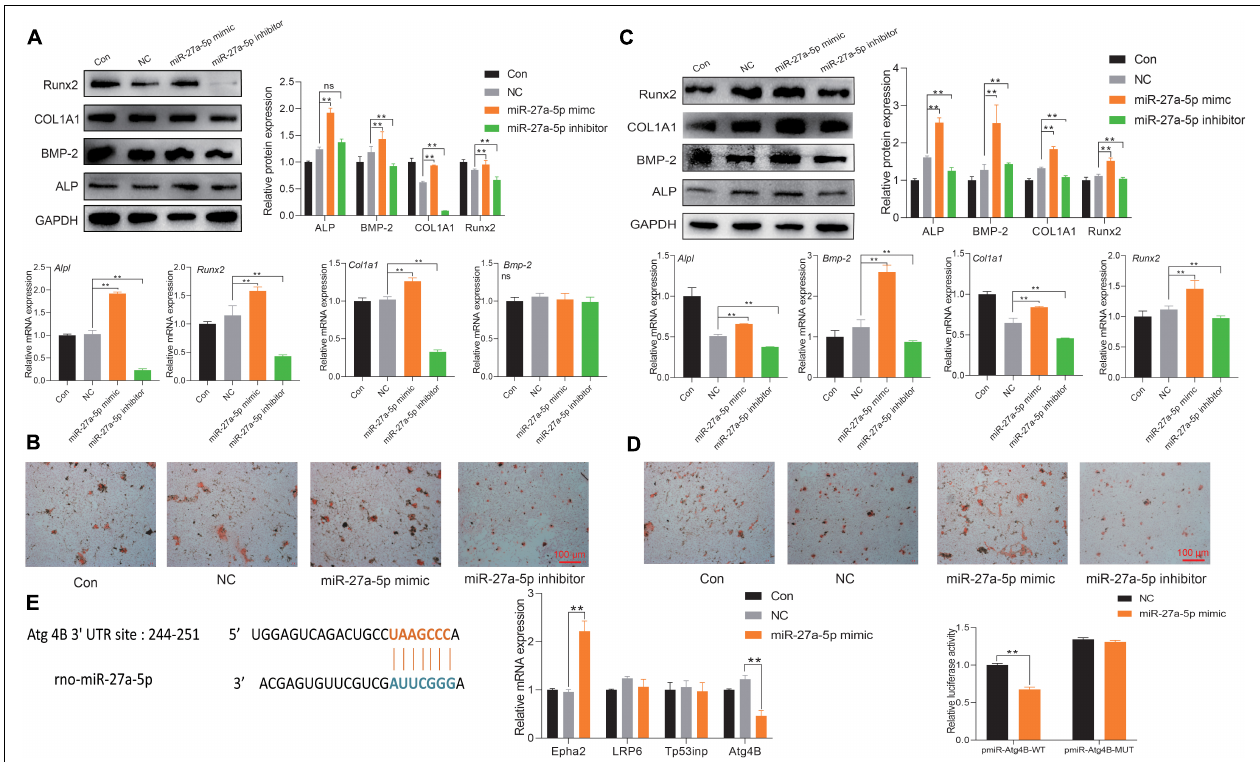
FIGURE 6 | miR-27a-5p targets Agt4B to promote osteogenic differentiation. (A) Protein and mRNA expression of osteogenic differentiation-related factor with the intervention of the miR-27a-5p mimic and inhibitor in BMSCs; the normalized data represented mean ± SD. (B) Alizarin Red S staining with the miR-27a-5p mimic and inhibitor in BMSCs; scale bar: 100 µ m. (C) Protein and mRNA expression of osteogenic differentiation-related factor with the miR-27a-5p mimic and inhibitor in osteoblasts; the normalized data represented mean ± SD. (D) Alizarin Red S staining with the miR-27a-5p mimic and inhibitor in osteoblasts; scale bar: 100 µ m. (E) Verification of Atg4B is the target gene of miR-27a-5p. * p < 0.05, ** p < 0.01; ns, non-significant; analyses were performed twice and obtained comparable